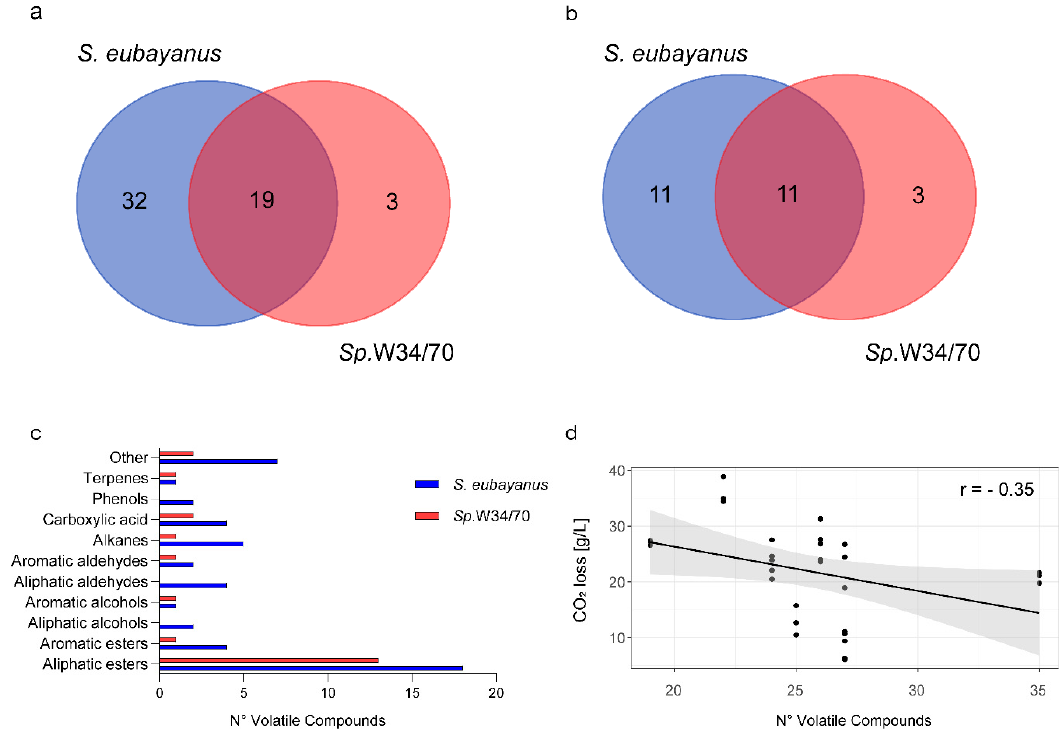
Figure 2. Volatile compounds identified in lager beer micro-fermentations using wild S. eubayanus and the Sp .W34/70 strain. ( a ) Total VCs identified in beer wort fermented by wild Chilean S. eubayanus (Blue) strains and S. pastorianus W34/70 (Red). ( b ) Total esters identified in beer wort fermented with wild Chilean S. eubayanus (Blue) strains and S. pastorianus W34/70 (Red). ( c ). Main chemical groups detected in fermented beer wort. ( d ) Correlation between the number of VCs produced and fermentative capacity. Each point depicts a biological replicate.